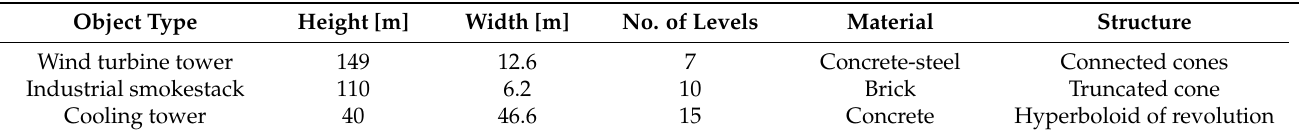
Table 1. Characteristics of the measured objects.